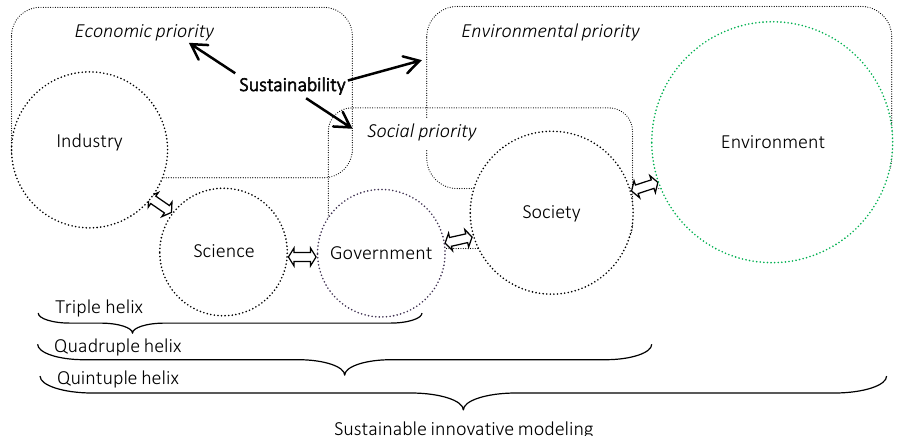
Figure 1. Relationship between the concept of sustainable development and helix